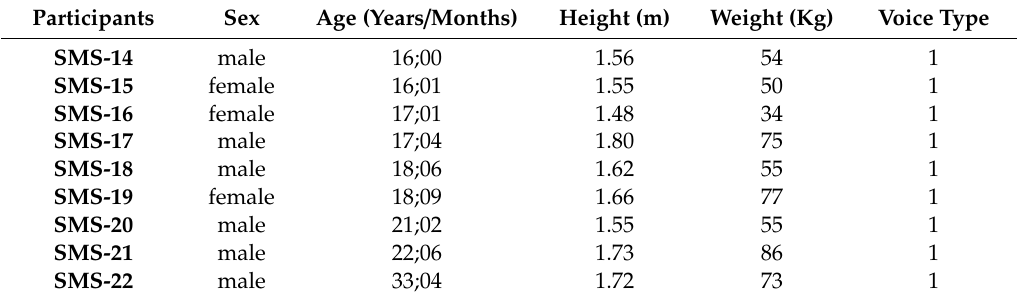
Table 3. Sex, age, height, weight and voice type of each participant with Smith–Magenis syndrome